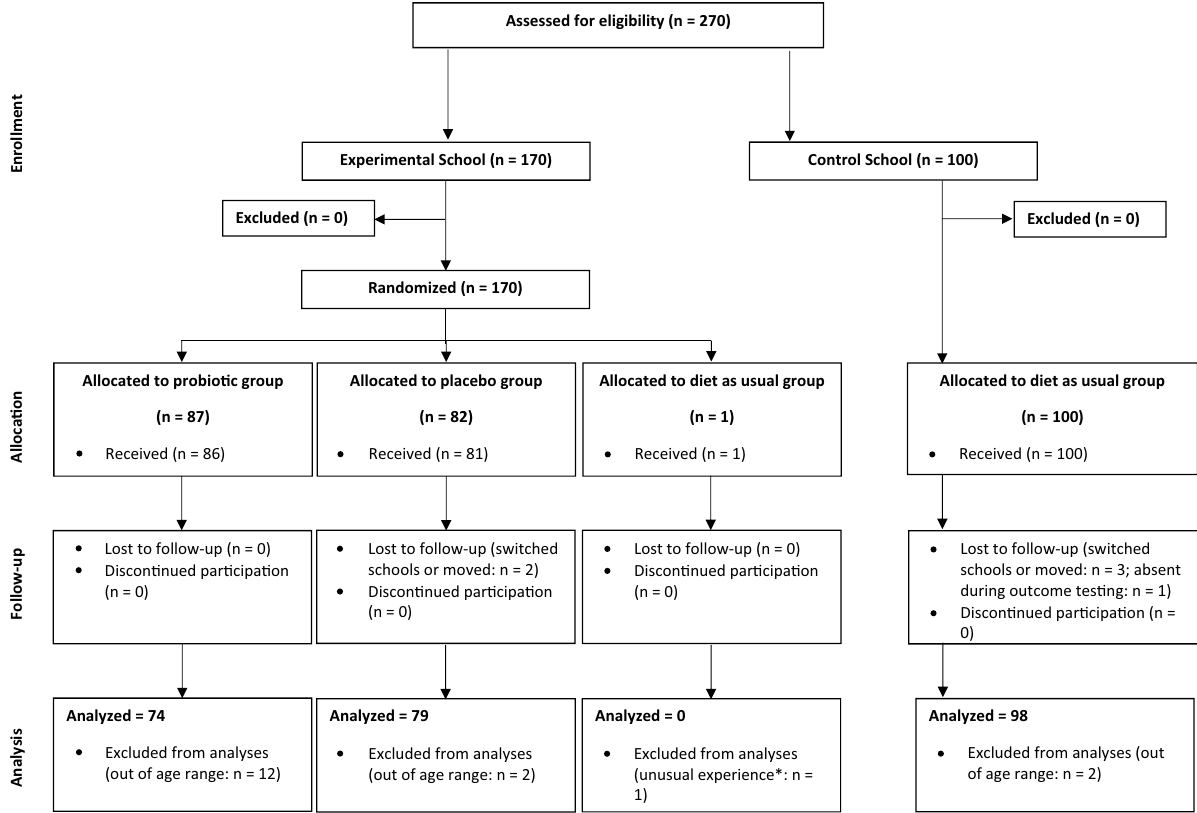
Figure 1. Consort participant flow diagram. Participants who were lost to follow-up are included in analyses. *One child in the experimental school was excluded because he was in the Diet as Usual group due to dietary issues. His experience was substantially different than all other Diet as Usual